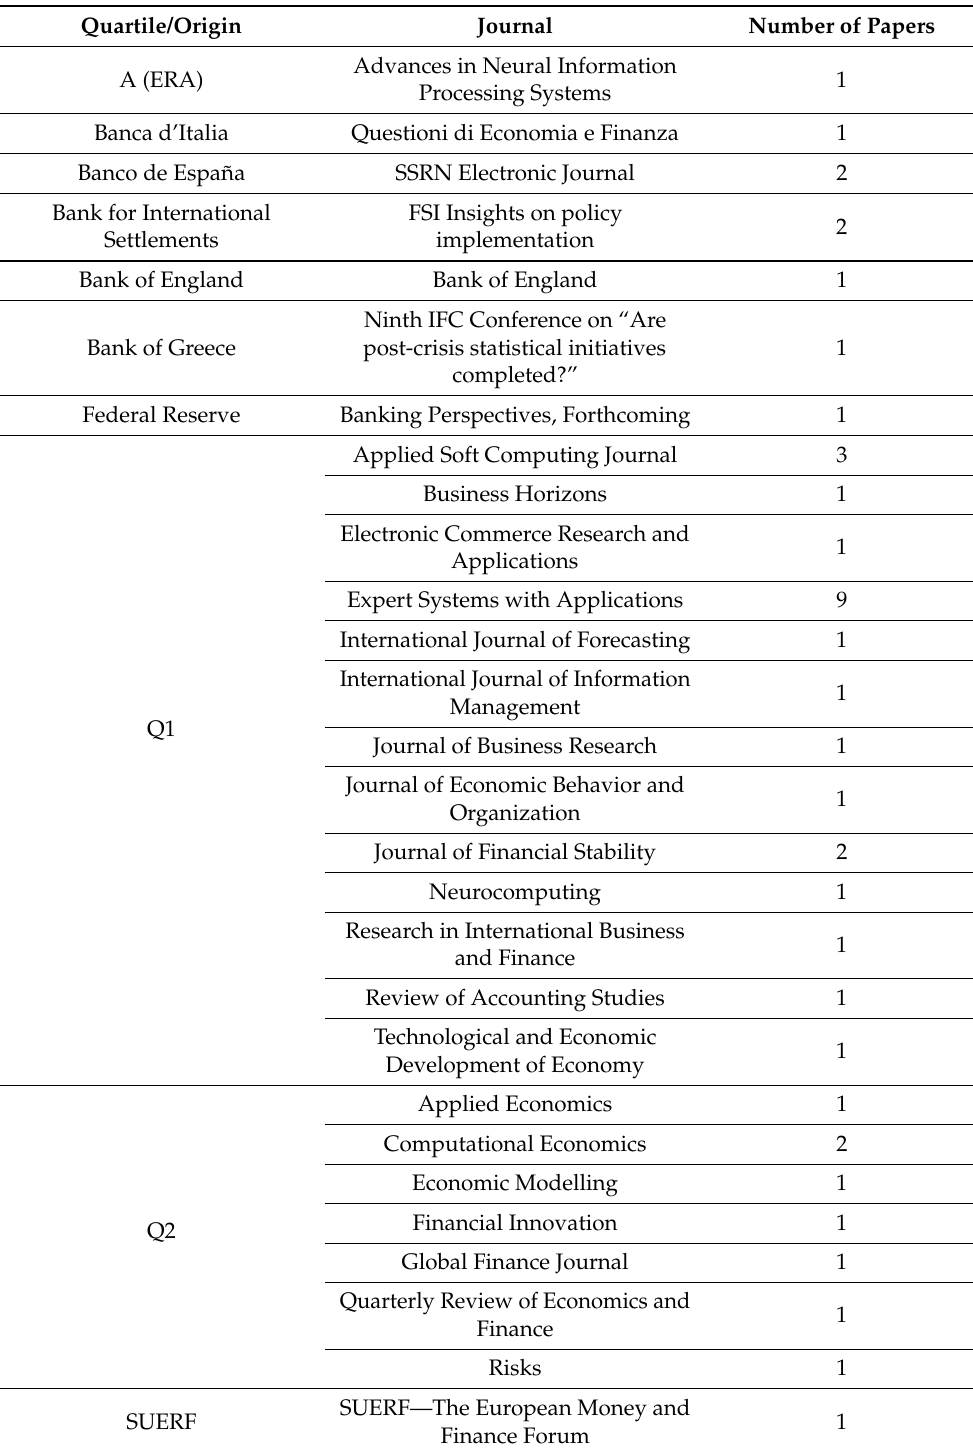
Table 3. Journals of the selected articles and their quartile. Where the journal is not indexed, the entity responsible for the publishing was